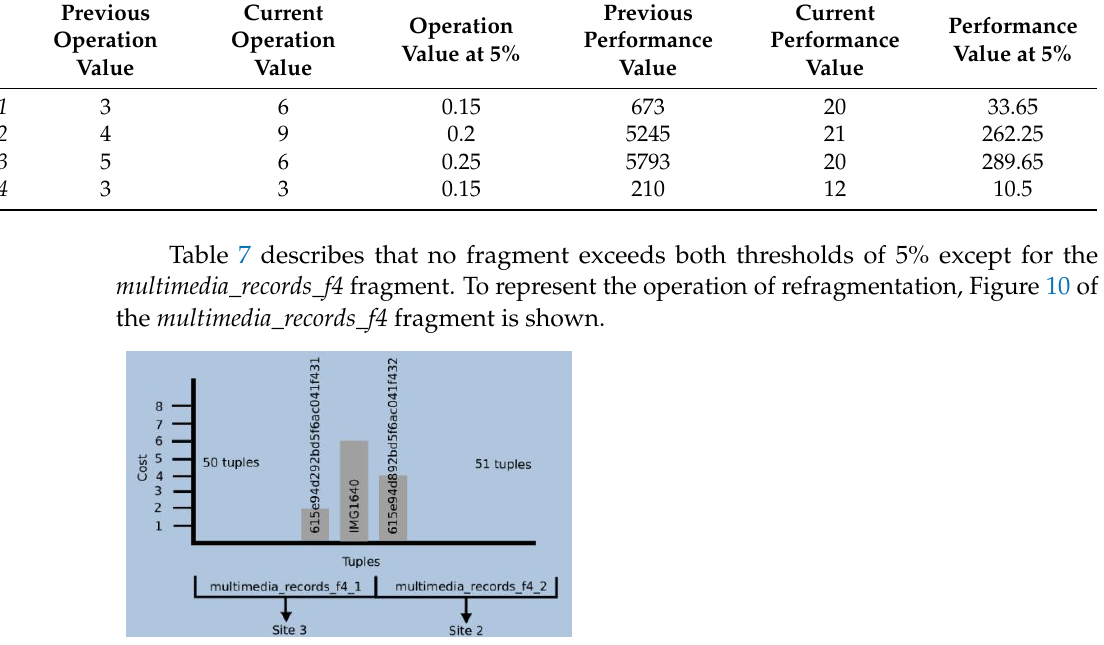
Table 7. Threshold analysis in dynamic fragmentation.